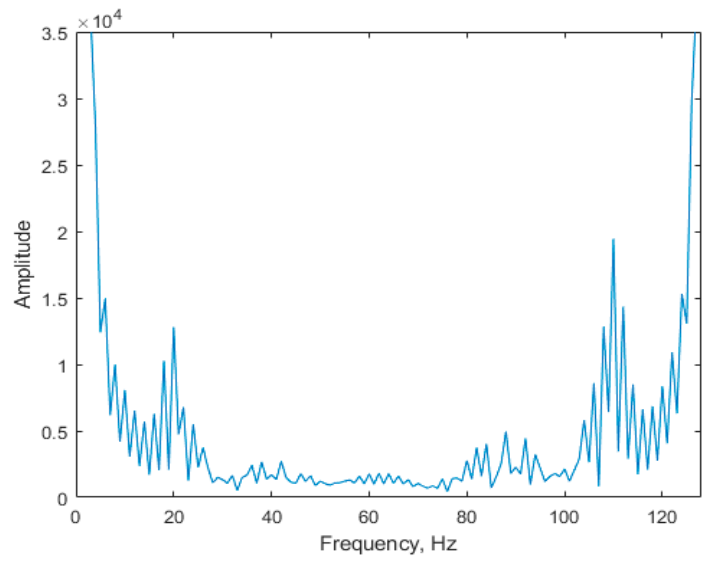
Figure 22. Amplitude spectrum of a received signal.